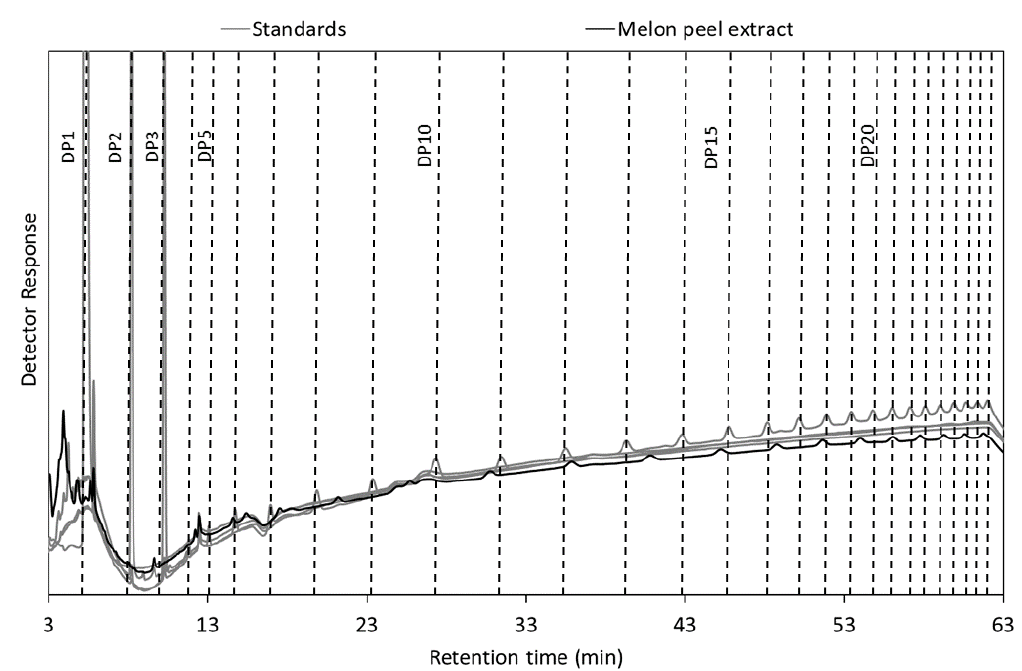
Figure 6. HPAEC–PAD of melon peel extracts and standards (DP1, DP2, DP3 and PGA).